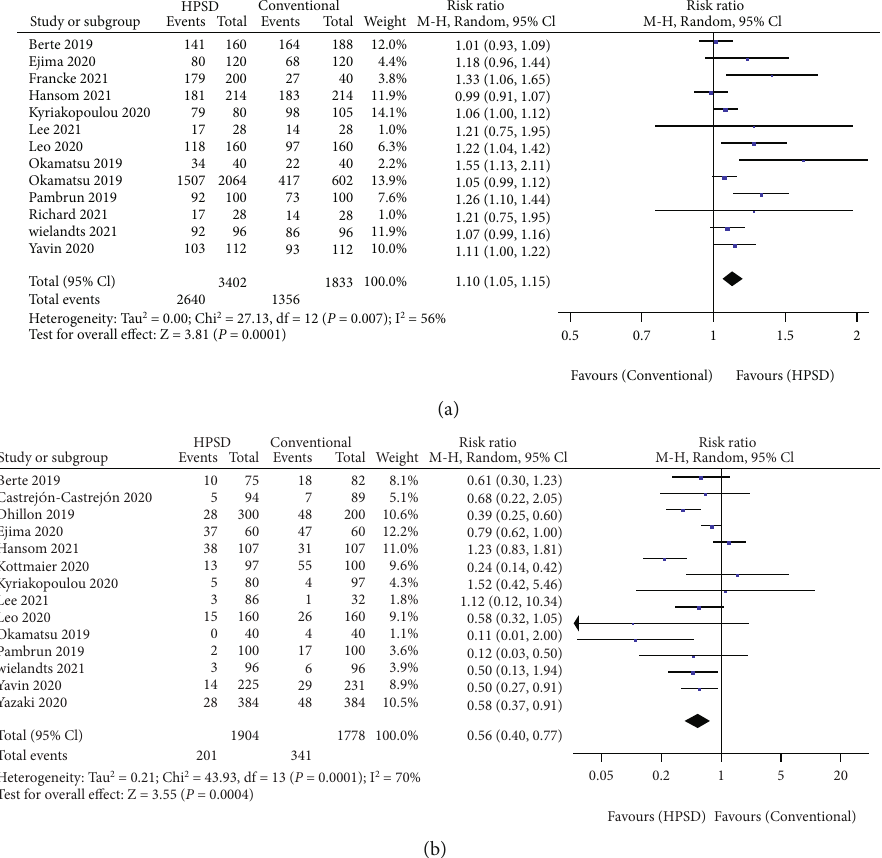
with conventional groups (for free from AF, RR = 1 : 17 , 95% CI: 1.07-1.27, I 2 = 32 %, and P = 0 : 0003 . For free from AT, RR = 1 : 11 , 95% CI: 1.05-1.17, I 2 = 32 %, and P < 0 : 0001 ) (Figures 3(a) and 3(b)). We performed subgroup analyses for 12 months free from AF and AT according to the ablation power setting and whether the ablation was guided by integral indexes or not. Either when the ablation power was set ≤ 45W or between 45W and 60W for left atrial walls except for posterior walls, HPSD groups showed better free from AF rate (for power ≤ 45 W, RR = 1 : 28 , 95% CI: 1.02-1.61, I 2 = 58 %, and P = 0 : 03 ; for 45 W < power < 60 W , RR = 1 : 10 , 95% CI: 1.01-1.19, I 2 = 0 %, and P = 0 : 03 , Supplementary Figure S3a). Although RR did not achieve a statistically signi fi cant di ff erence between the two subgroups ( P = 0 : 21 ), the 45 W < power < 60 W subgroup did not show heterogeneity inside the group while the other group remained high heterogeneity. Higher free from AT rate was also observed in both subgroups (for power ≤ 45 W, RR = 1 : 17 , 95% CI: 1.01-1.36, I 2 = 63 %, and P = 0 : 04 ; for 45 W < power < 60 W , RR = 1 : 09 , 95% CI: 1.04- 1.14, I 2 = 3 %, and P = 0 : 0006 , Supplementary Figure S3b) compared with conventional groups. Similarly, the 45 W < power < 60 W subgroup showed minor heterogeneity while the ≤ 45W group remained high heterogeneity.